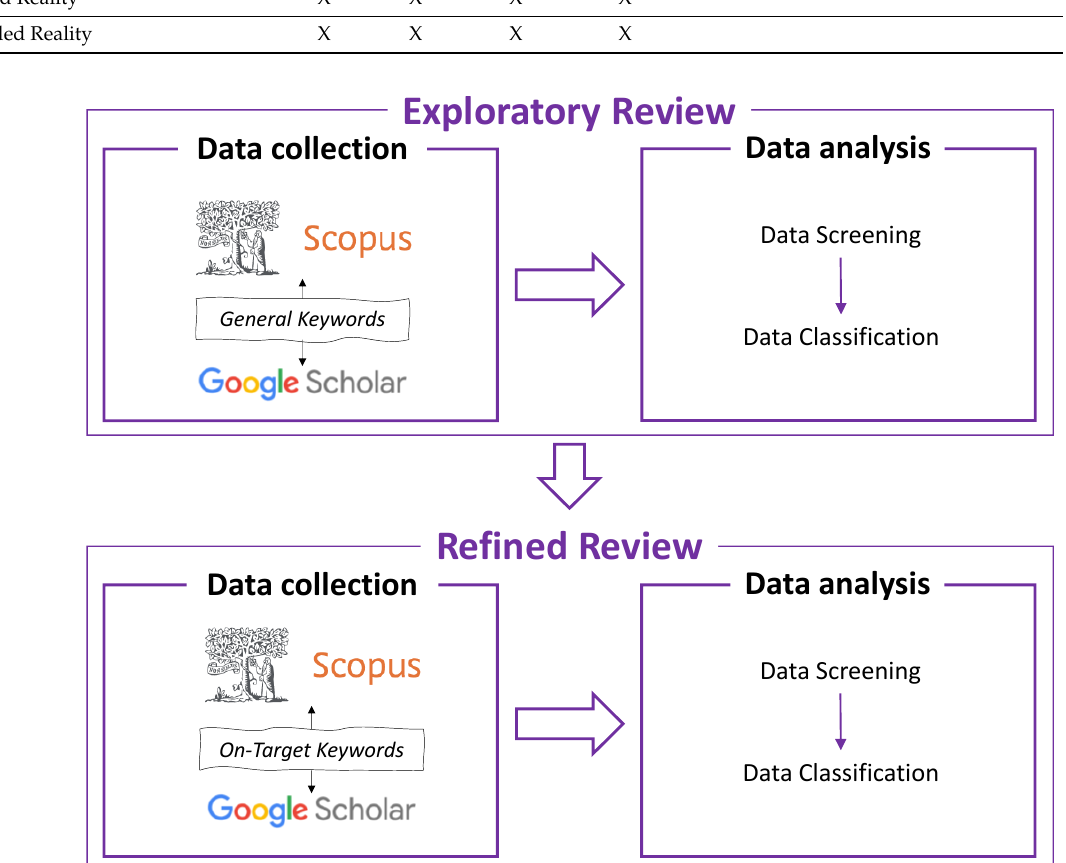
Figure 6. Overview of research methodology. Table 1. General keywords used in the literature search for the Exploratory Review.